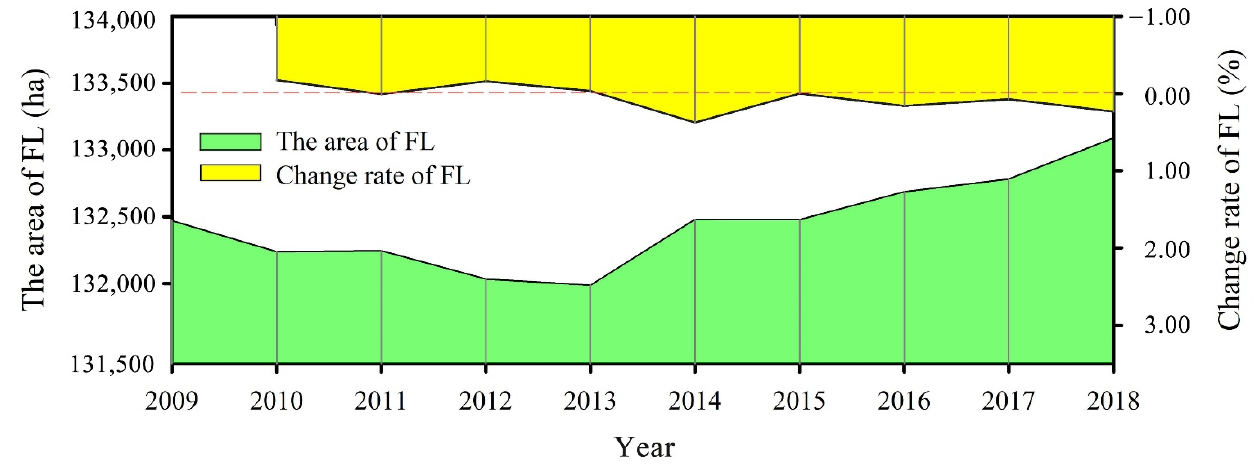
Figure 2. Changes in the area of farmland (FL) in Sihong from 2009 to 2018 .